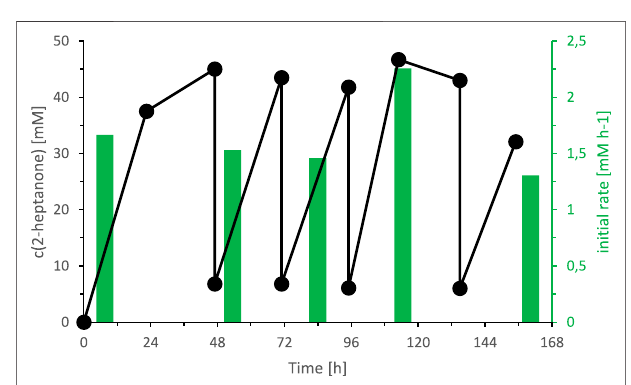
FIGURE 10 | Effect of replacing the organic layer on the Sy ADH catalysed oxidationof rac -heptan-2-olinabiphasicreactionsystem.Reaction conditions: [ rac -heptan-2-ol] org = 50 mM, [ethyl acetoacetate] org = 50 mM (1 equiv.), the organic phase was replaced at t = 47, 72, 96 and 135 h, [NADP + ] aq = 1 mM, [ E. coli C43(DE3) pET24b- syadh ] aq = 5 mg×mL − 1 , [KPi, pH 7] =1 M (10% v/v),[ n- heptane]=90% v/v, total volume: 500 μ L, T=30 ° C, 600